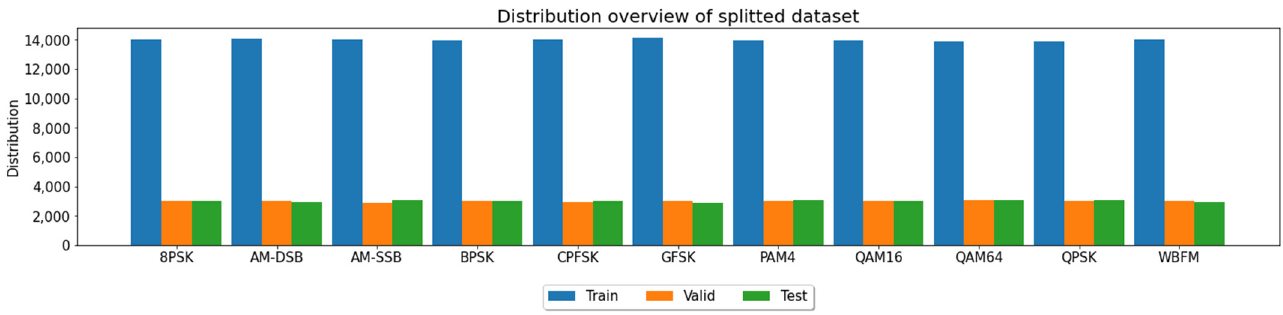
Figure 18. Dataset split distribution.